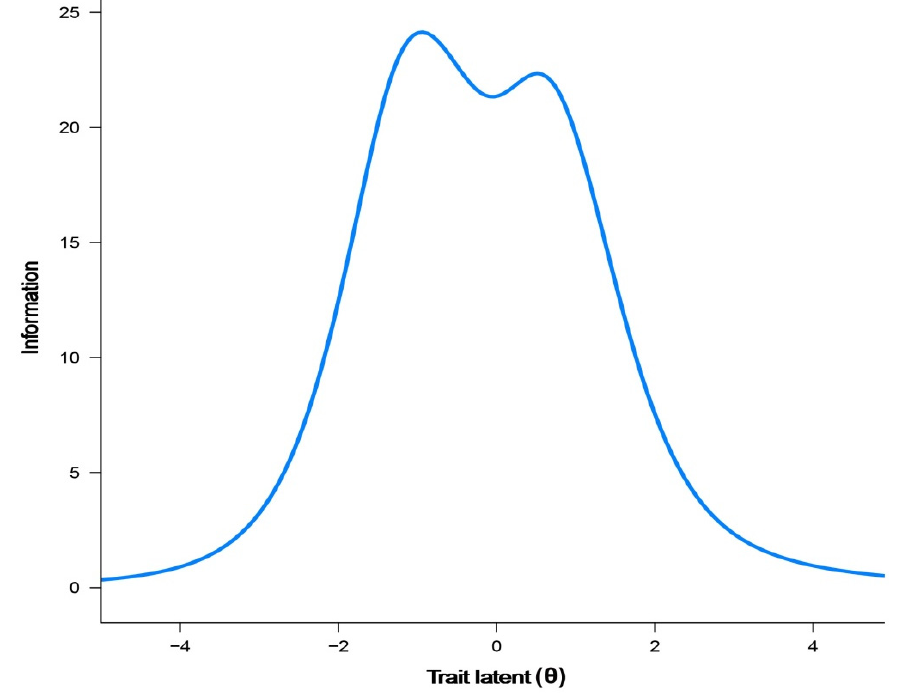
Figure 2. Test information curve of the final PREMIUM-DT item bank.